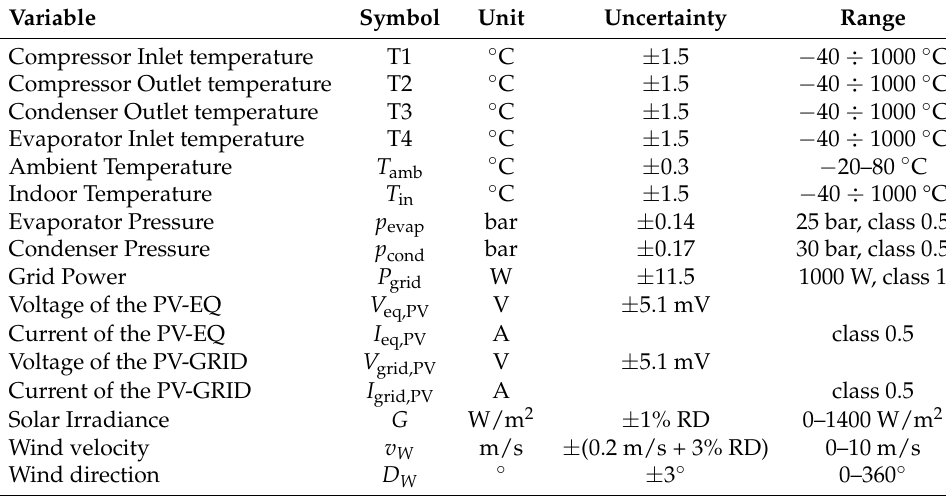
Table 1. Specifications of the sensor used during the experimental tests (Aguilar et al. [8]).